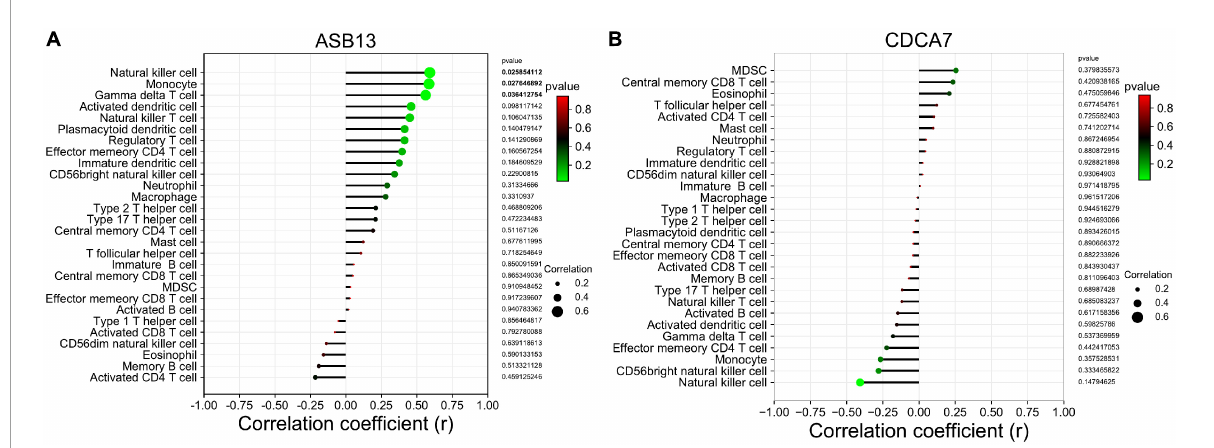
FIGURE6 Correlation between hub programmed cell death (PCD)-related prognostic genes and infiltrating immune cells in extracorporeal membrane oxygenation (ECMO) treatment for acute myocardial infarction (AMI). (A) Immune correlation analysis of ankyrin repeat and SOCS box containing 13 (ASB13). (B) Immune correlation analysis of cell division cycle associated 7